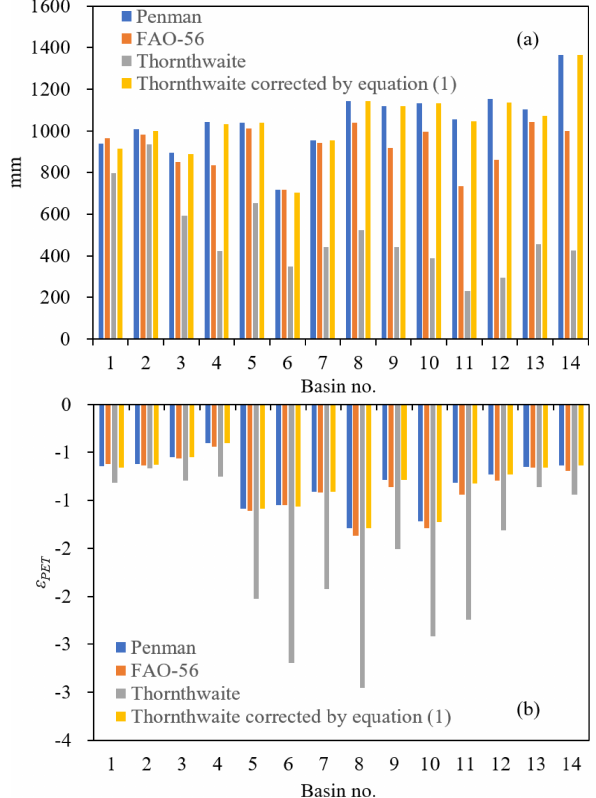
Figure 13. (a) Mean annual PET calculated from the four meth- ods for the 14 river basins of China during the period 1960–2008. (b) PET elasticity calculated from Eq. (2) based on the four PET data for the 14 river basins of China during the period 1960–2008. The basin number is consistent with that given in Fig.